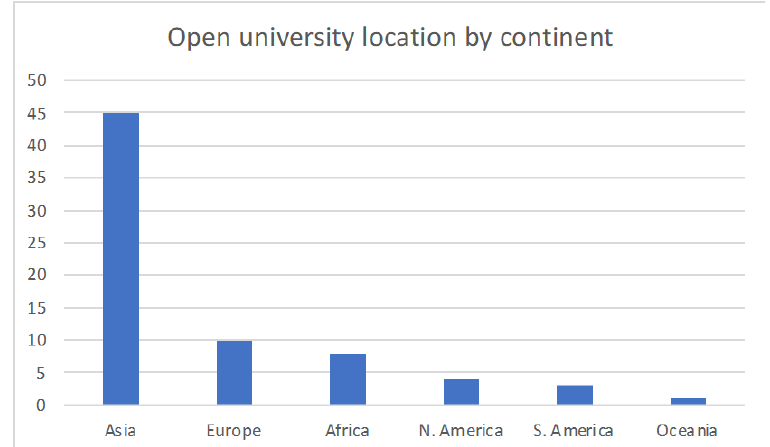
Figure 1. Open university location by